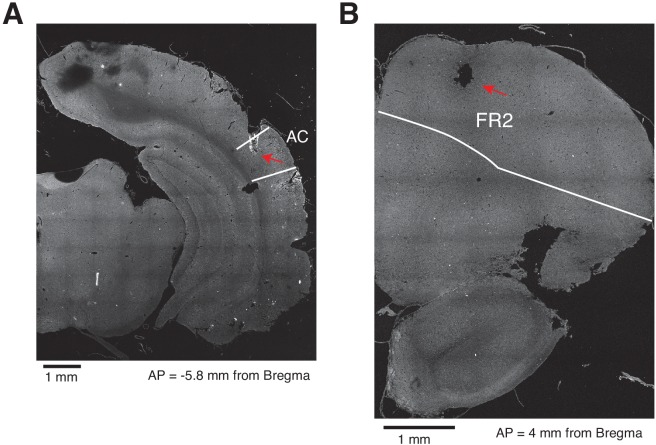
Histological placement of cannulas in AC and FR2.(A) Example of a coronal section of a rat implanted with cannulas in primary auditory cortex (AC). The white lines represent the borders of AC38. (B) Example of a coronal section of a rat implanted with cannulas in FR2. The white lines represent the borders of FR238.